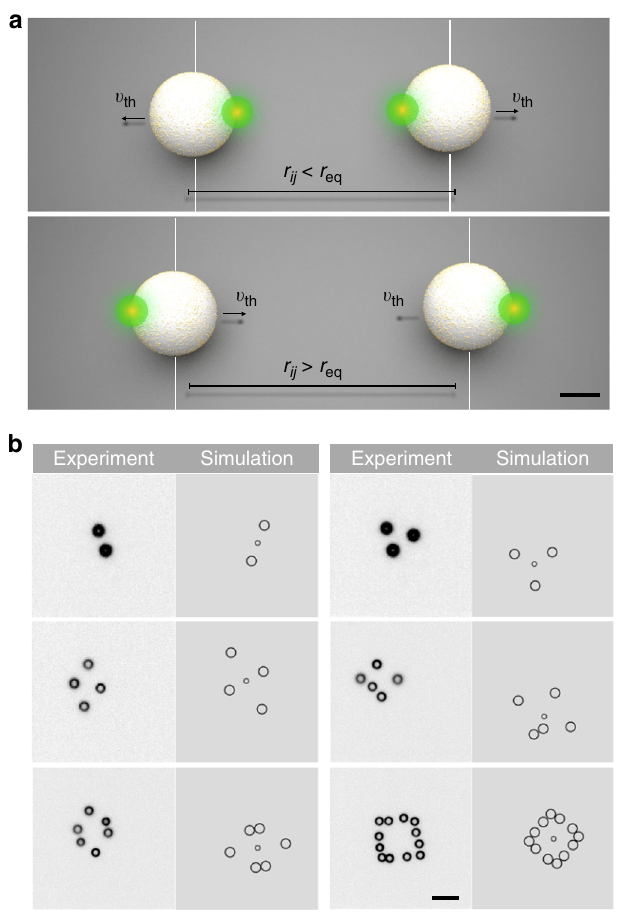
Fig. 3 Feedback rule and self-organized active particle structures. a Pair interaction rule used to “ bind ” the active particles to each other. Particles are propelled with a speed v th . If the distance is below r eq , the particles are moved away from each other, if above, they are propelled towards each other. The scale bar has a length of 1 μ m. b Example snapshots of 6 different “ active particle molecules ” that are bound by the interaction rule in a . The structures are highly dynamic (see Supplementary Movies 4 – 9). The scale bar has a length of 7 μ m. The experimental images are compared to snapshots of corresponding numerical simulations involving Brownian motion and a simple delayed feedback as in the experiment (not drawn to scale, see Supplementary Note 2). The smaller central circle marks the center of mass. An effective potential description (not included) also reveals equivalent structures up to the particles. The interaction rule is implemented in a real-time particle tracking loop (Methods) detecting the center positions of the active particles and steering the heating laser to the corre- sponding spots at their circumferences. Position measurements and action are separated by one exposure time Δ t exp introducing the feedback delay δ t = Δ t exp .